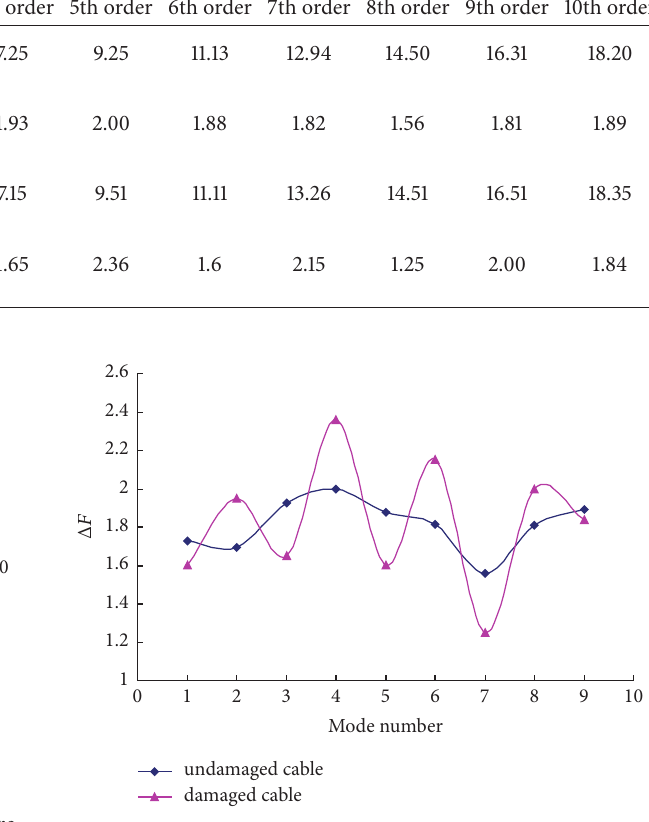
Figure 11: Neighbouring frequency interval of both